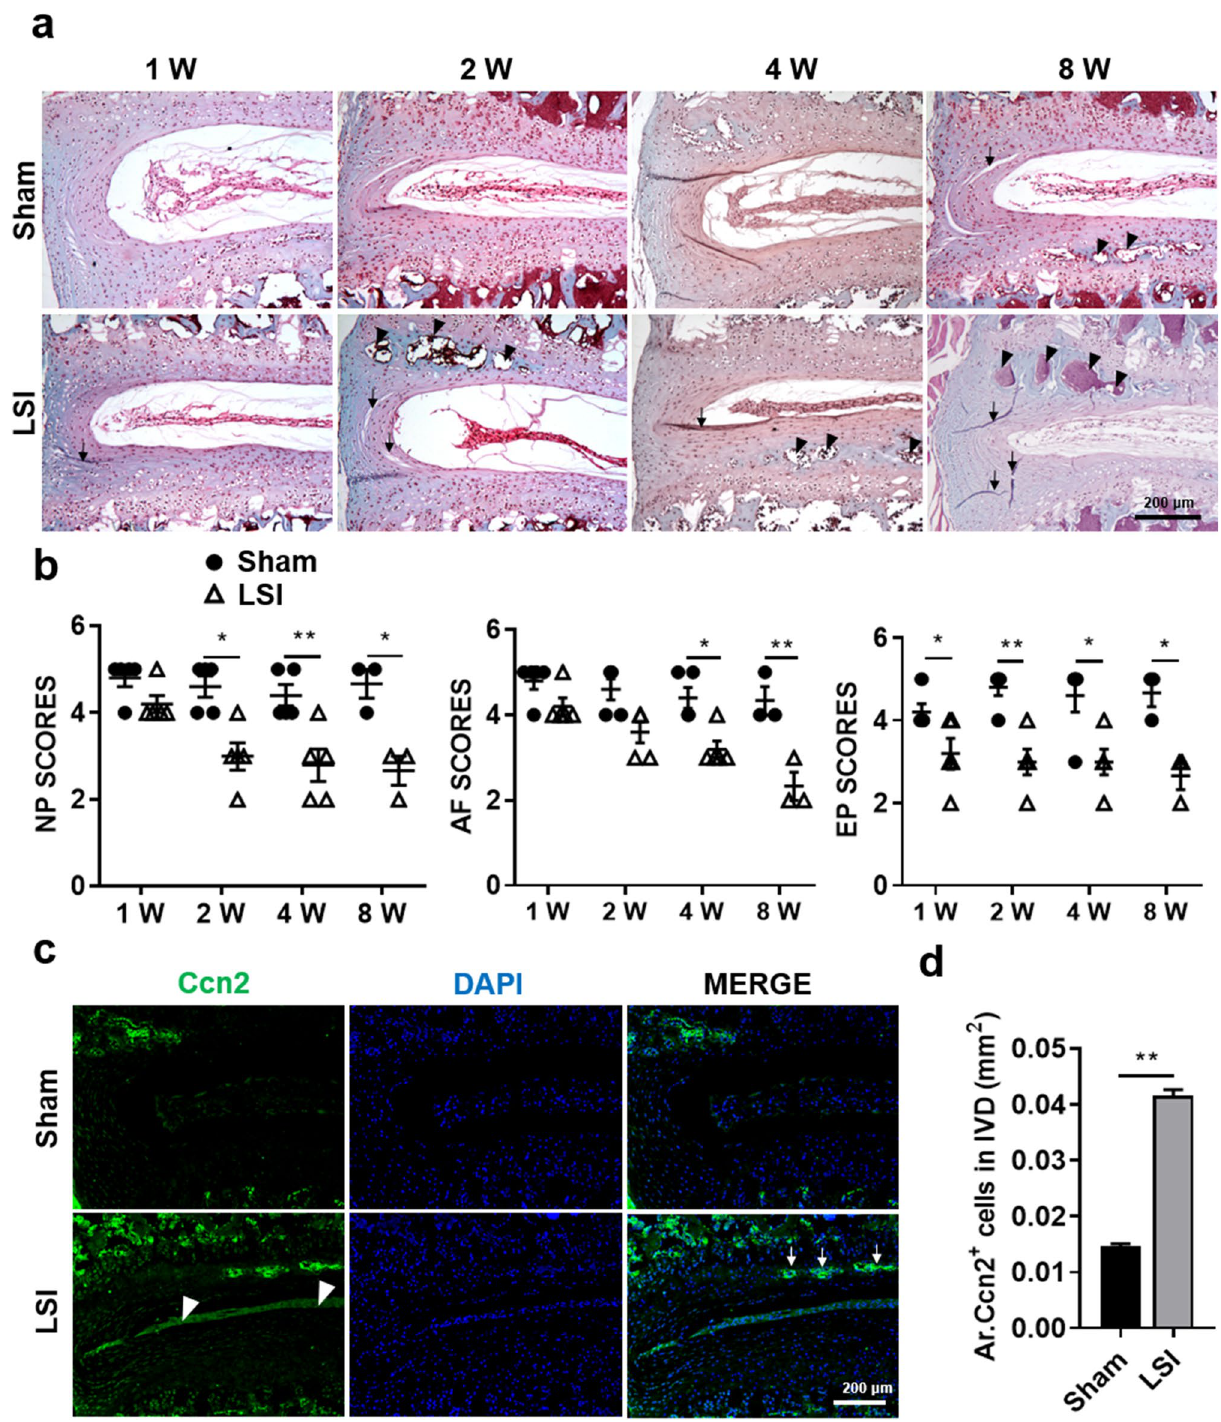
Figure 2. Aberrant mechanical stress disruptes the morphology of the intervertebral disc and activates Ccn2 expression. ( a ) Representative Safranin O staining images of the IVD sections showing the changes of IVD cells in Sham and LSI mice at 1-, 2-, 4- and 8-W post-surgery. Black arrows indicate tearing in AF. Black arrow heads indicate ectopic bone formation in EP. ( b ) Evaluation of IVD degeneration by NP, AF and EP score. ( c ) Immunofluorescence staining for Ccn2 expression (green) at 4-W post-surgery. DAPI stains nuclei blue. White arrows indicate high expression of Ccn2 in the ectopic bone formation zone of EP. White arrowheads indicate high expression of Ccn2 in NP tissues. ( d ) Quantification of Ccn2-positive cells in IVD of ( c ). The averages of integrated optical density in interest region was calculated by Image-Pro Plus software version 6.0 (https ://www. media cy.com). Data are shown as mean ± sem. Three independent experiments performed in triplicate. * P < 0.05, ** P < 0.01 compared to Sham